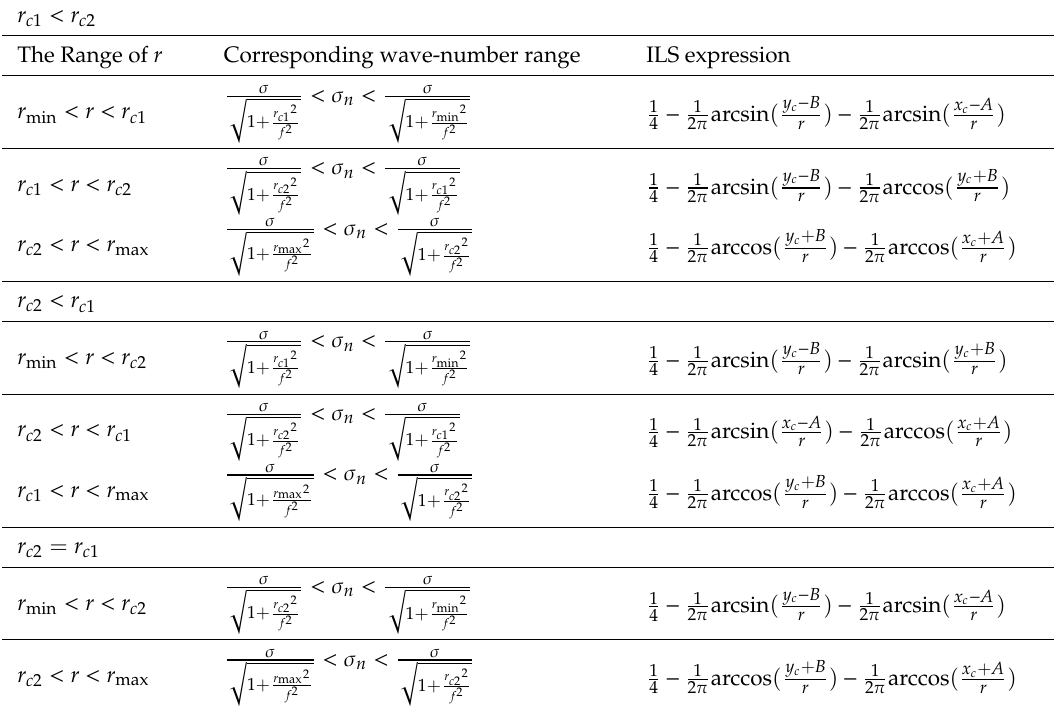
Table A1. ILS expressions of the square detector for o ff -axis